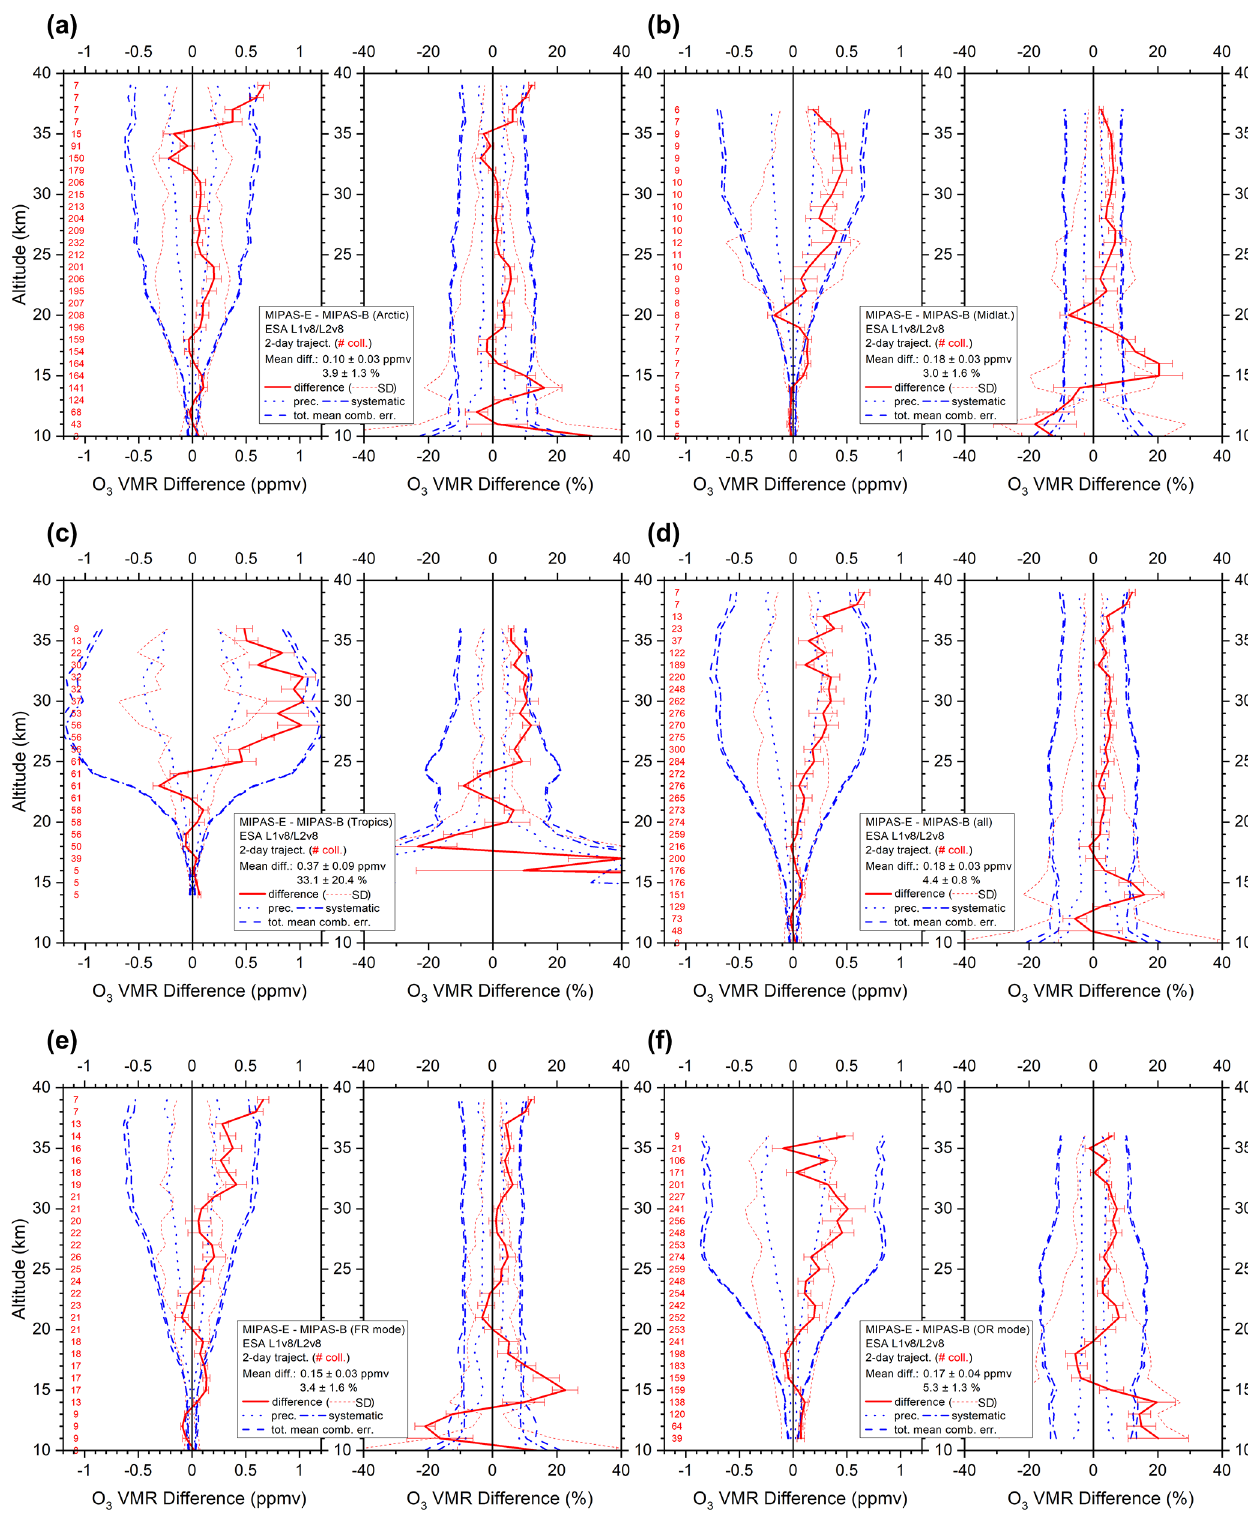
Figure 4. Same as Fig. 3 but for O 3